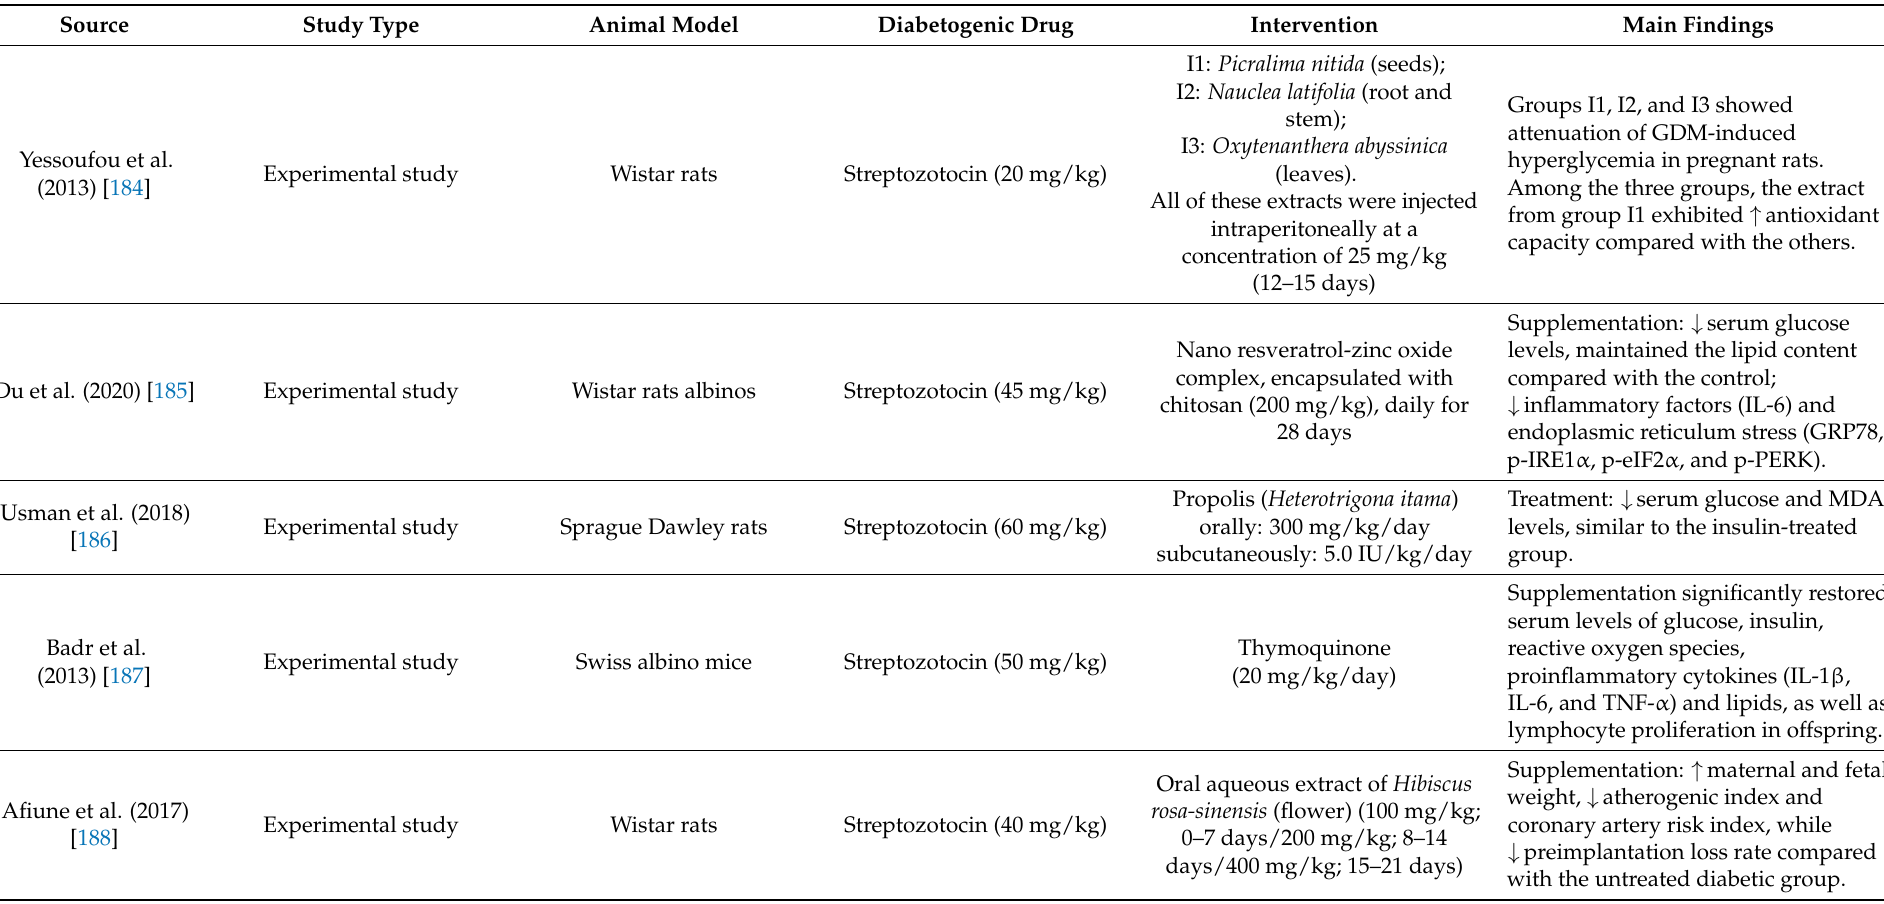
Table 3. Alternative therapies used in animal models with induced